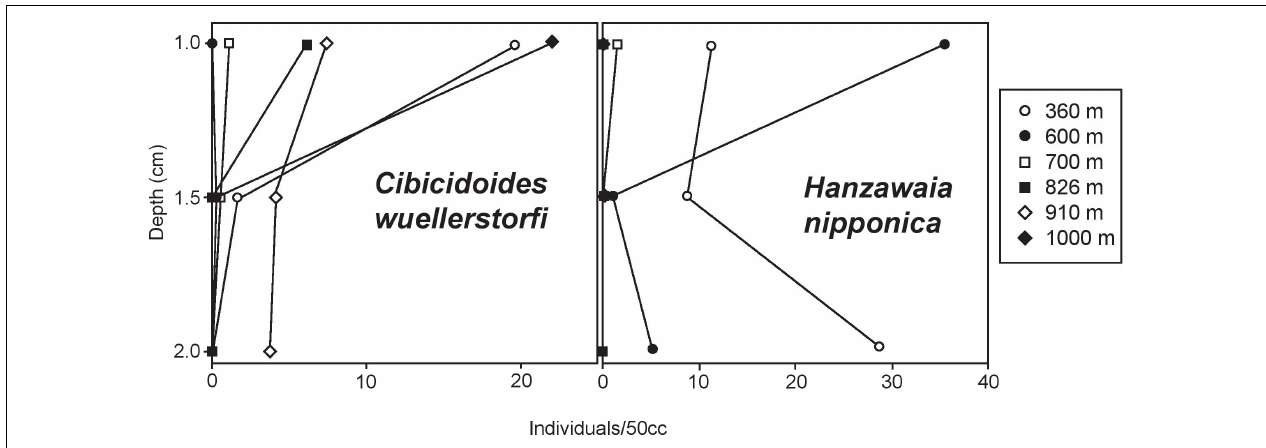
FIGURE 9 | Epifaunal foraminiferal verticle distribution within the top 2 cm of sediments analyzed from multicores at six sites along our transect. Epifaunal microhabitat preferences of C. wuellerstorfi are consistent with previous studies. Maximum abundances of H. nipponica in the top cm of sediment were observed at most sites, with the exception of 360 m, suggesting that this taxon can also be described as epifaunal.